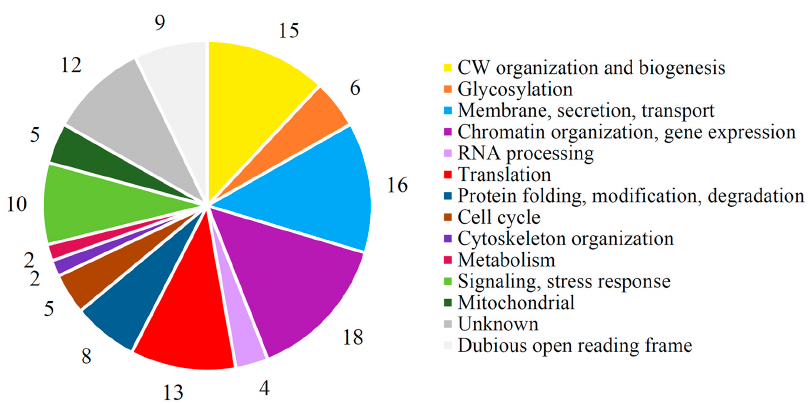
Figure 5. Distribution of cellular processes and cellular components involved in the action of K66 toxin. The number of genes identified in each class is indicated.